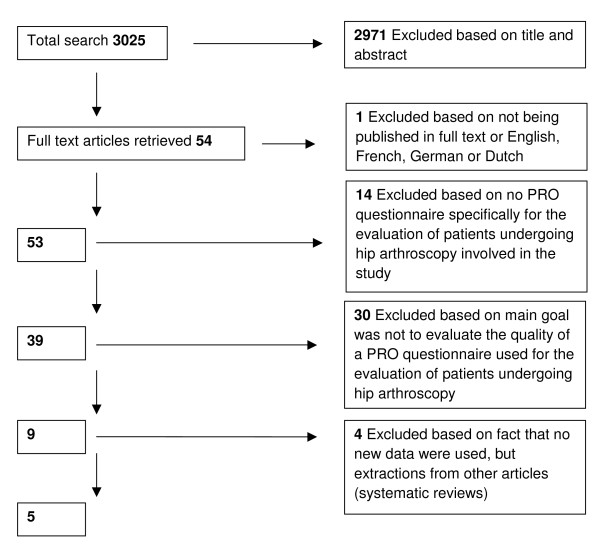
Selection of publications with exclusion criteria